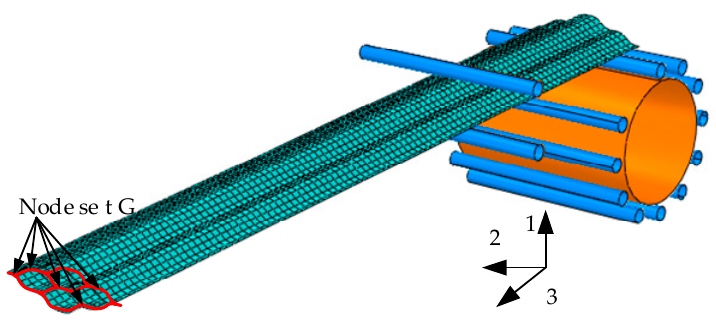
Figure 5. FE Figure 5. FE model. Figure 5. FE model.